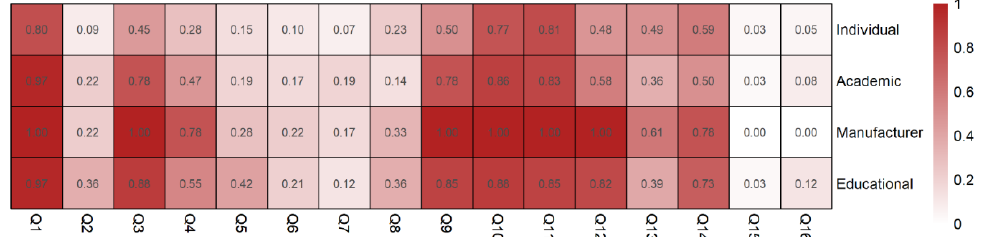
Figure 2. Heatmap of brachial plexus block specific quality scores according to video sources. The X -axis represents each question and Y -axis represents the video source. The number in the box represents the percentage of questions addressed. The color is intensified as the percentage increases.